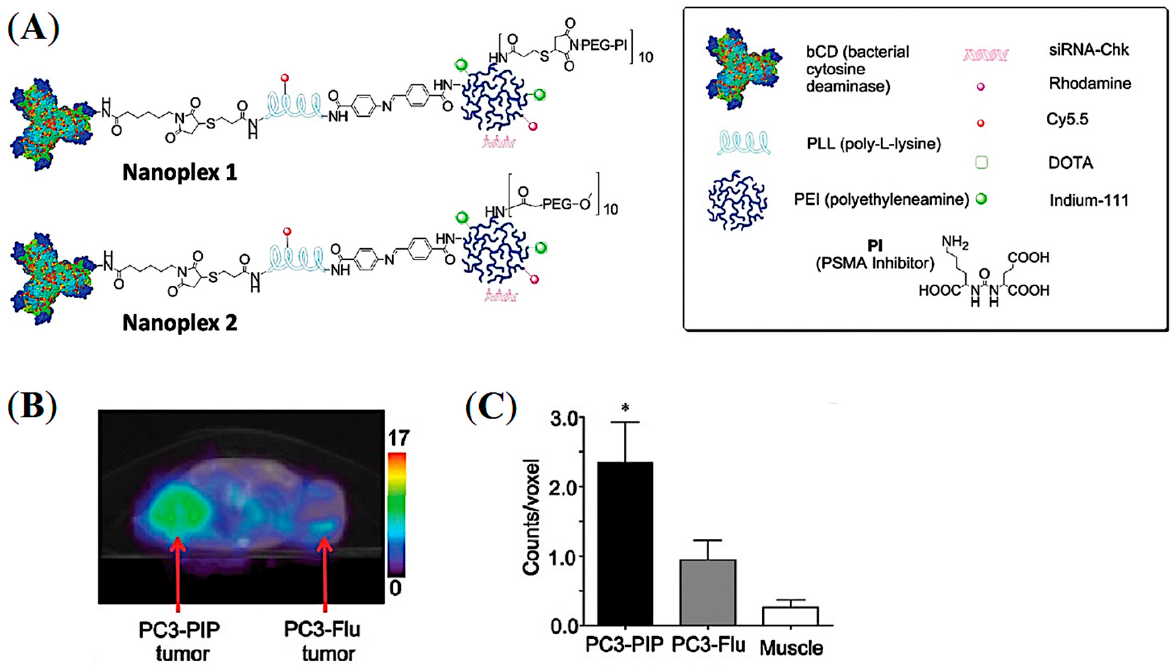
Figure 11. PSMA-targeted nanoplex for combined imaging and treatment of PCa using a prodrug enzyme strategy and siRNA. ( A ) Schematic representation of the PSMA-targeted nanoplex 1 and 2. ( B ) Transaxial mSPECT/CT images of the targeted 111 In-labelled nanoplex 1 at 48 h post-injection in SCID mouse bearing PC3-PIP and PC3-Flu tumors. ( C ) ROI on tumors and muscle at 48 h post- injection ( n = 4, * p < 0.05). Reprinted with permission from Ref [67]. Copyright 2012, American Chemical Society.